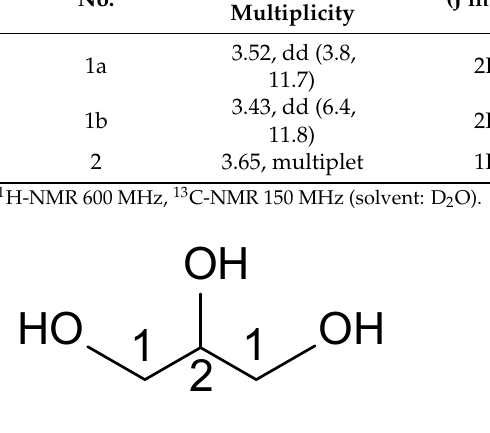
Figure 5. The structure of glycerol.